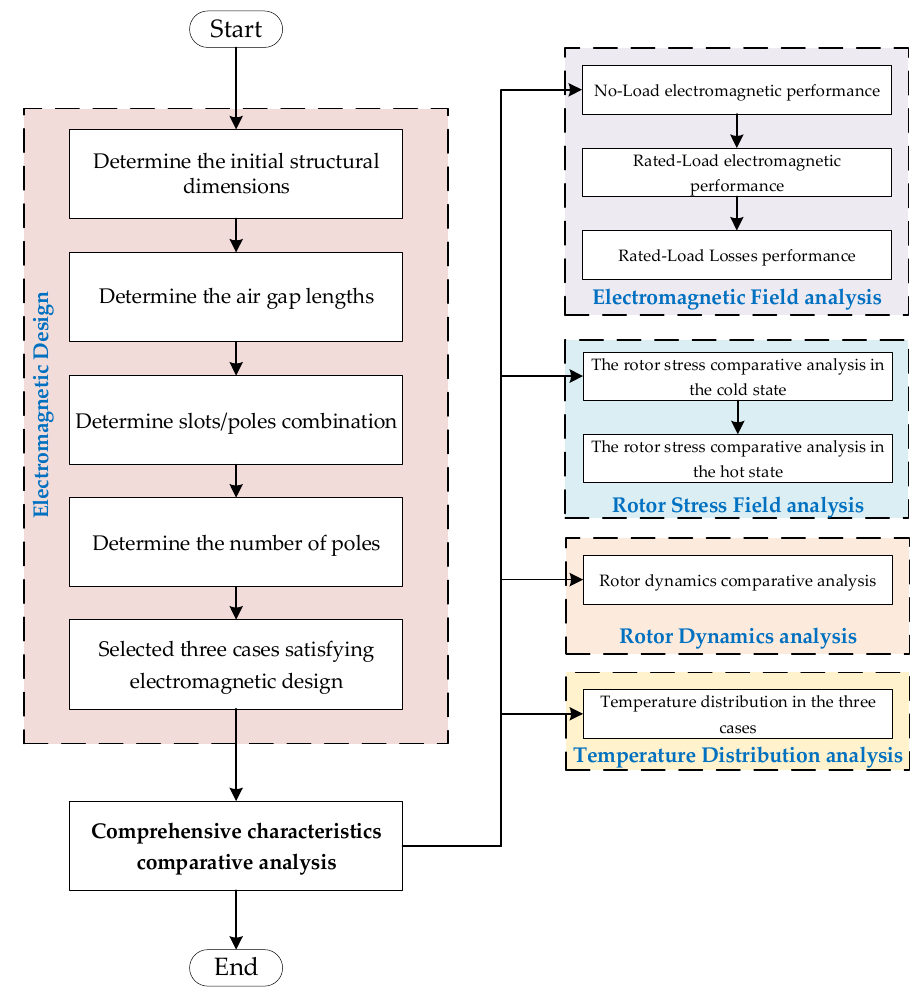
Figure 1. Comprehensive characteristics comparative analysis and design process.